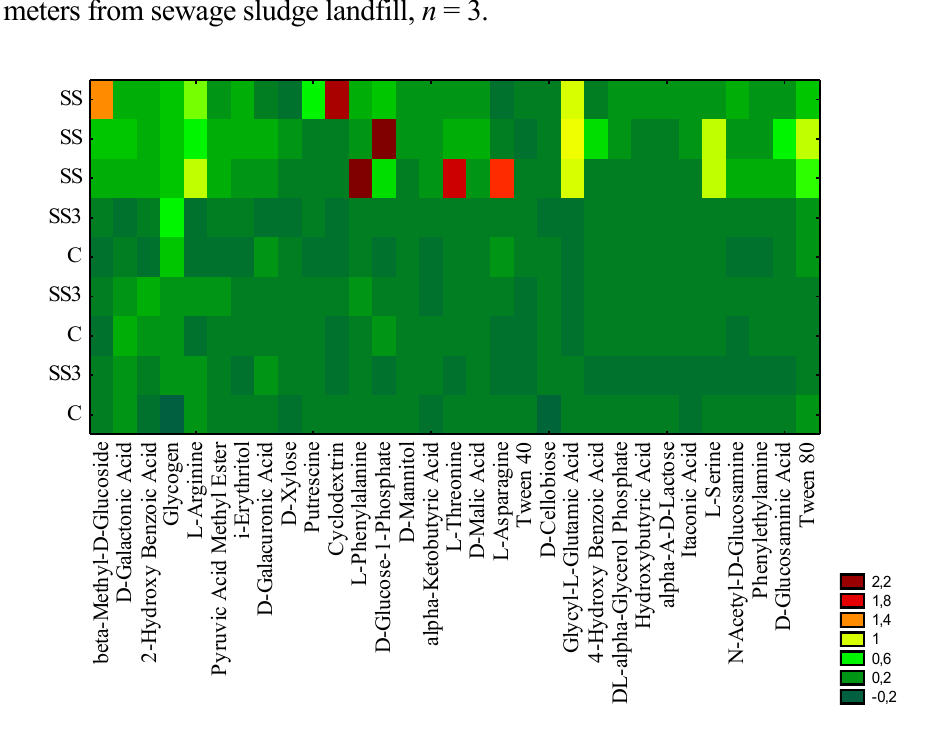
Figure 5. Biolog EcoPlate TM carbon source utilization intensity diagram. SS—soil under sewage sludge accumulation, SS3—soil 3 meters from the sewage sludge landfill, C—control soil 200 meters from sewage sludge landfill, n = 3.